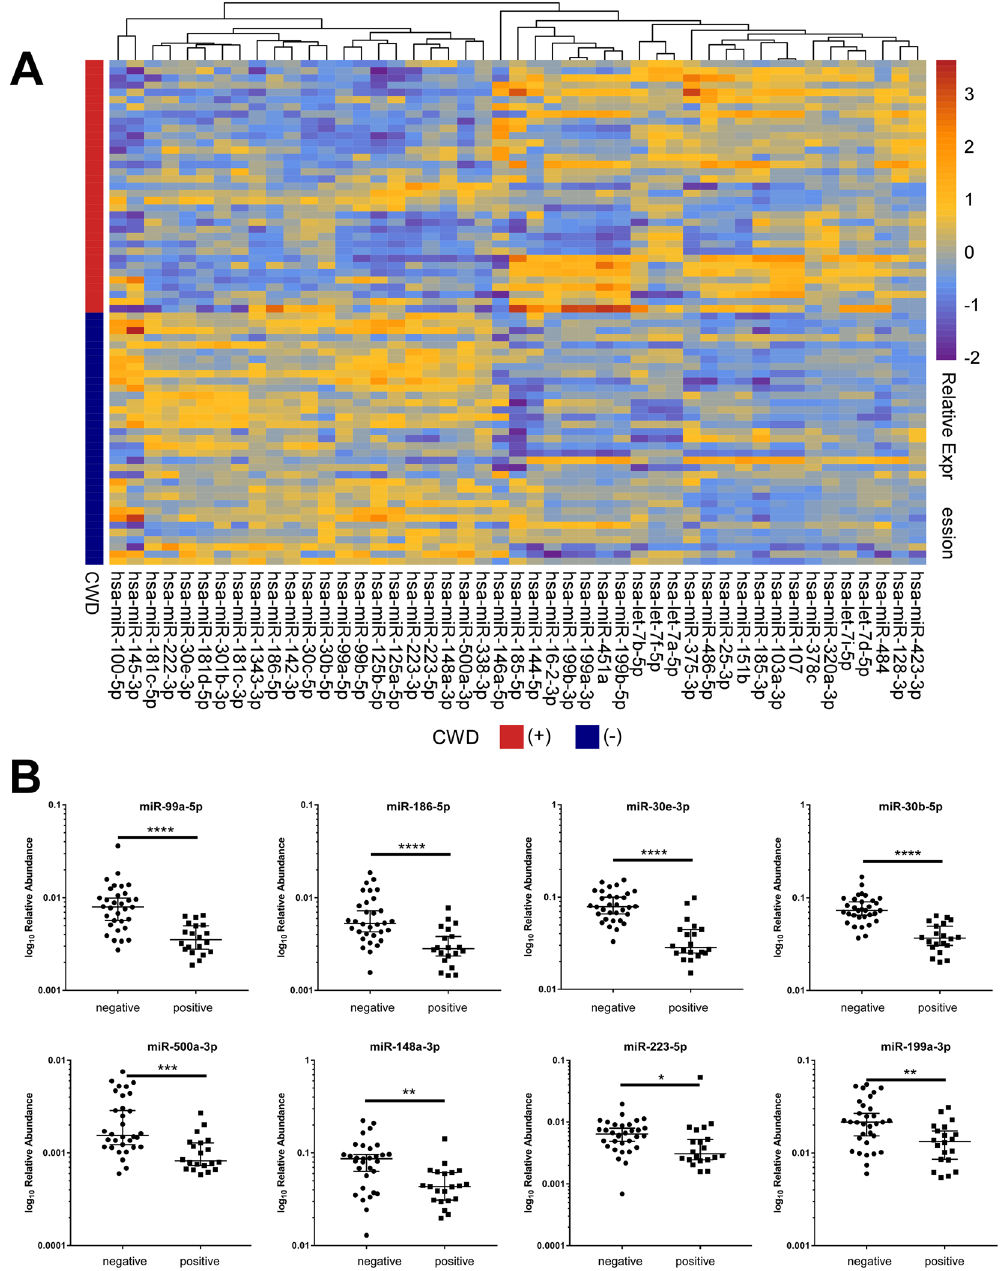
Figure 2. Differentially expressed miRNA in serum from CWD infected elk. ( A ) Hierarchical clustering using relative log transformed read count of 47 differentially expressed miRNAs reveals an alternate pattern of abundance in serum taken from elk that were CWD positive by IHC. ( B ) Increases of 8 miRNAs in CWD positive elk confirmed by qRT-PCR. Serum miRNA levels were reported as relative miRNA concentration, with the formula 2 −Δ Ct normalized to miR-23a-3p. The log10 relative abundance was plotted and significant median differences in the miRNA levels between each group determined by the nonparametric Mann-Whitney test ( * p < 0.05, ** p < 0.01, *** p < 0.001, **** p < 0.0001). The levels of miR-423-3p, miR-486-5p, miR125a-5p and miR-30-5p were